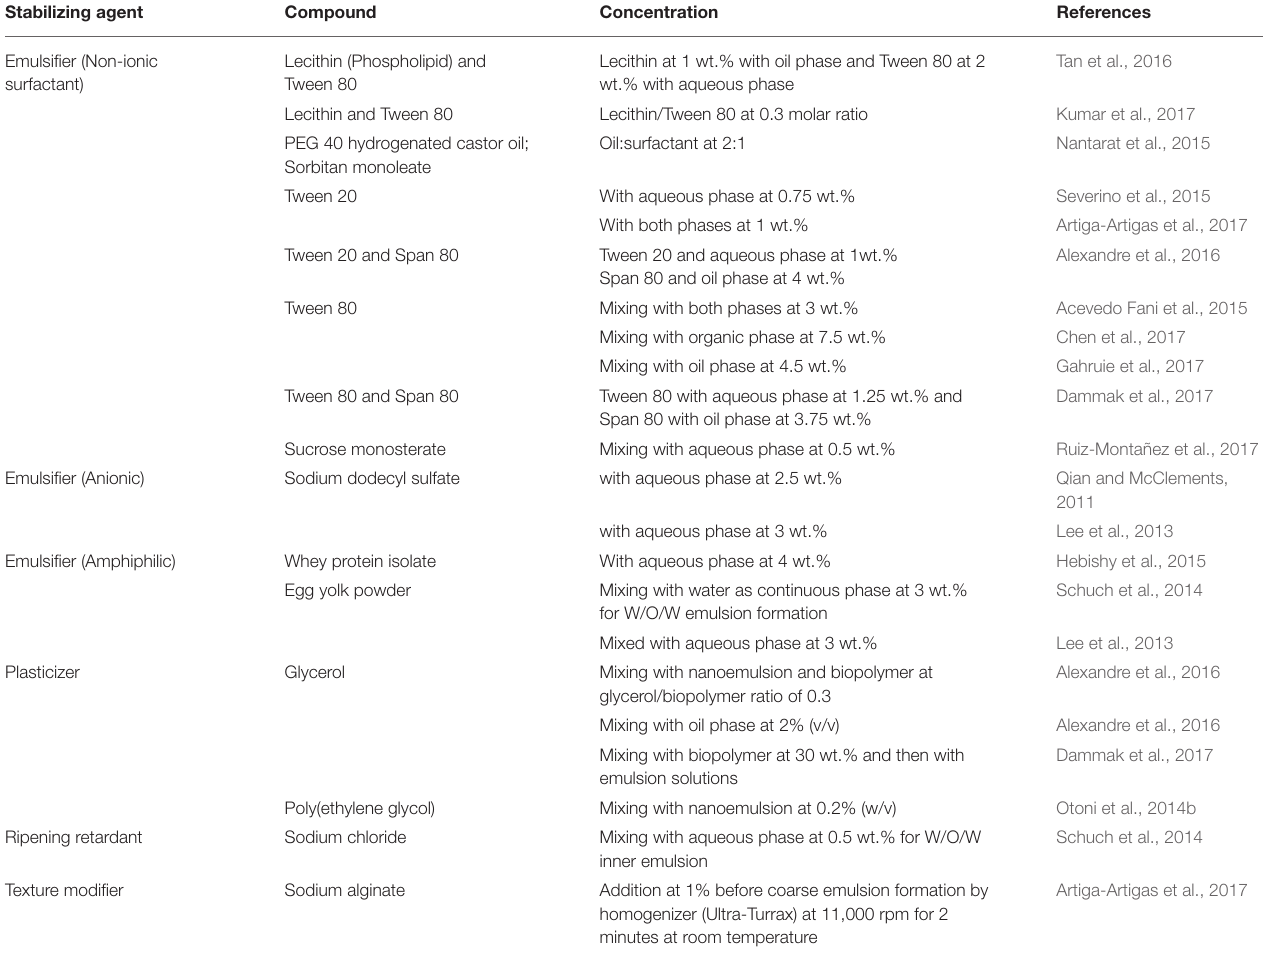
TABLE 2 | Food grade stabilizing agents used in nanoemulsions preparations for food related